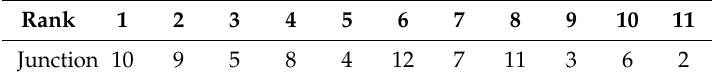
Figure 2. Flowchart for the determination of monitoring location using pressure contribution analysis. Table 4. Results of pressure contribution analysis.